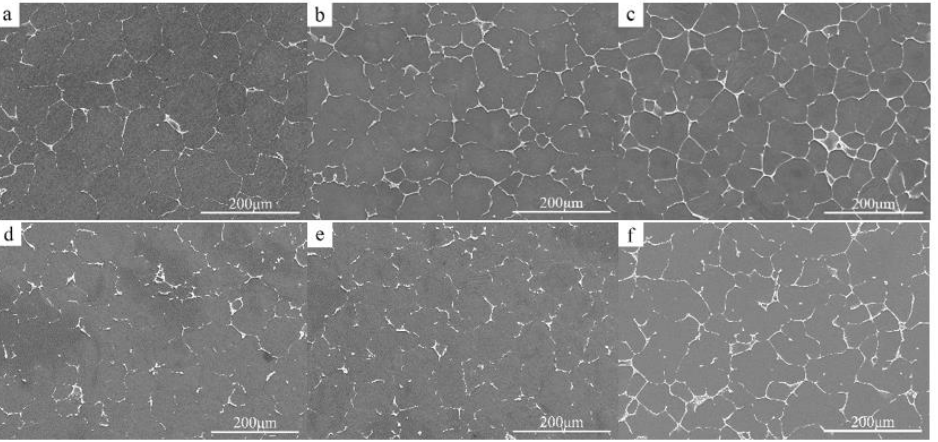
Figure 2. SEM microstructure images of the as-cast alloys. ( a ) ZCI, ( b ) ZCII, ( c ) ZCIII, ( d ) ZCIV, ( e ) ZCV, ( f ) ZCVI.